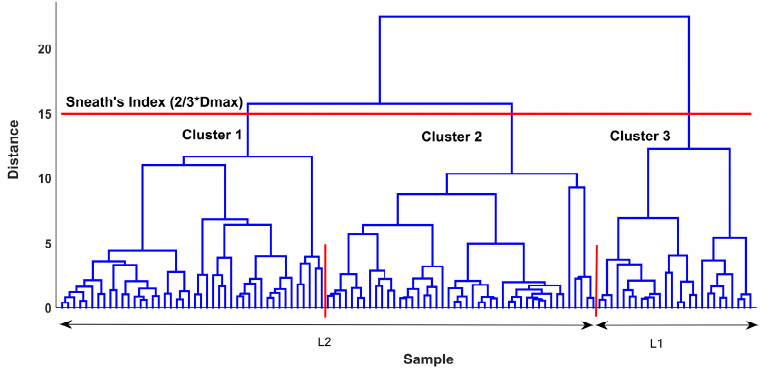
Figure 5. A dendrogram of similarity for the data samples from Lake Megali Prespa (L1) and Lake Mikri Prespa (L2). Based on Sneath’s criterion (red horizontal line), three clusters are formed (separated by the red vertical solid lines). Dmax : maximum distance.